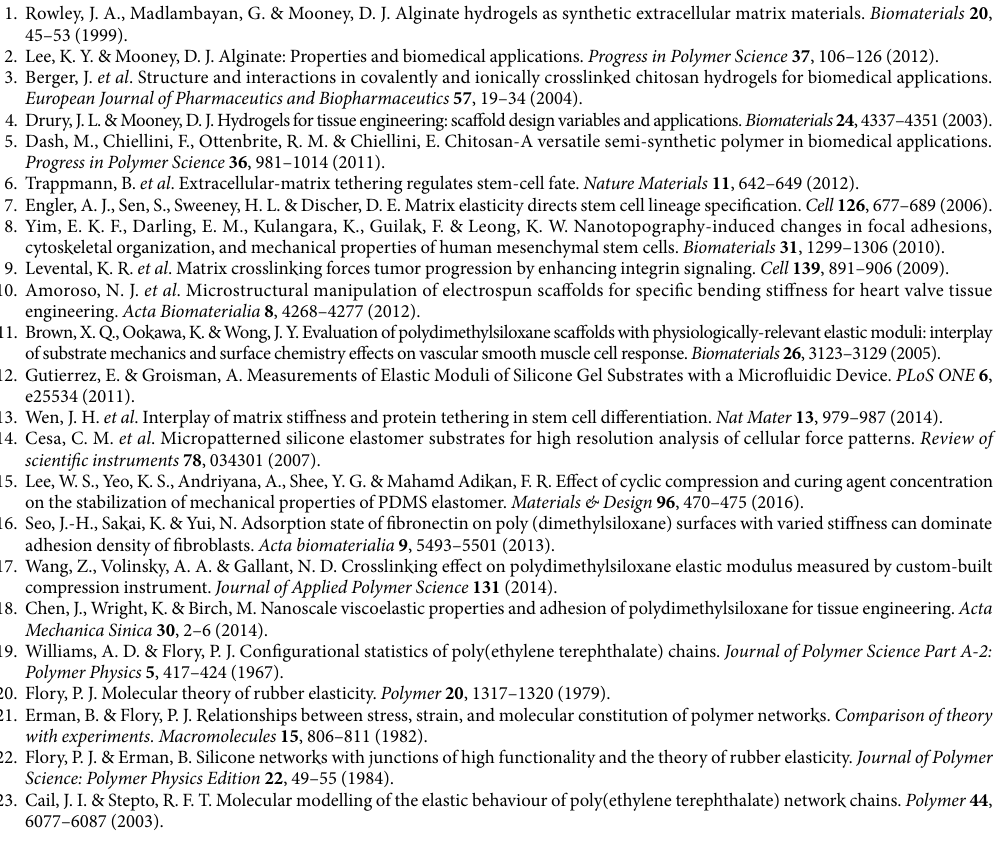
of magnitude smaller than the probe diameter 51 .